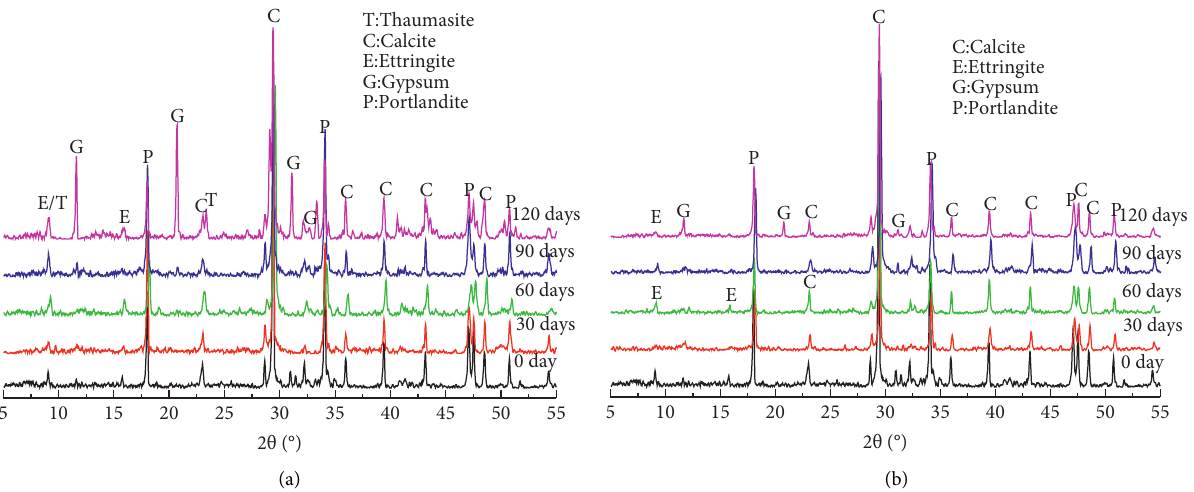
Figure 11: XRD pattern of 15% limestone powder content within 120 days. (a) Cathode surface and (b) anode